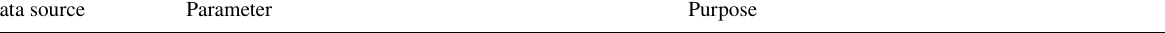
Table 1 Data sources of reservoir geomechanical model construction1 The data source